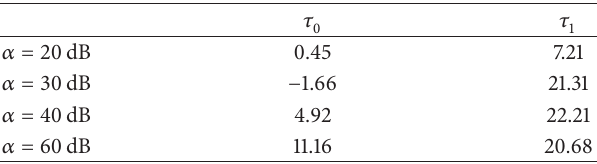
Table 5: Parameter values of the linear delay spread model in terms of the threshold level ( 𝛼 ).